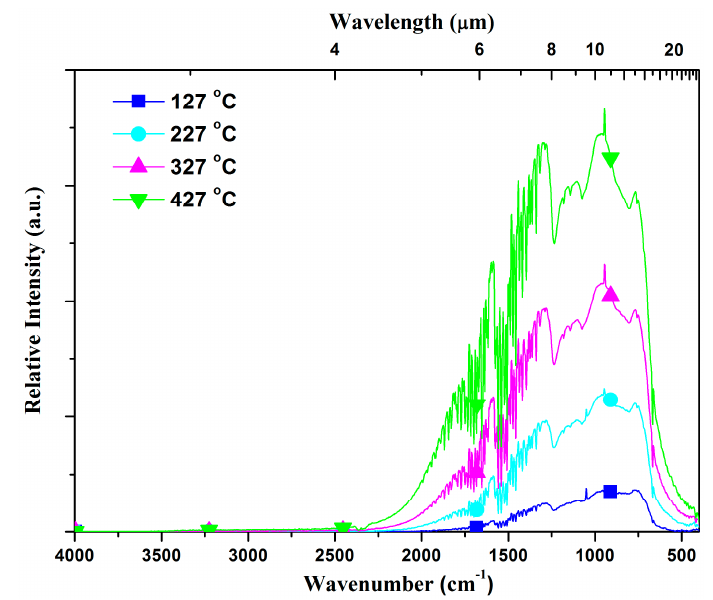
Figure 7. Infrared radiation intensity of a transparent 3Y-TZP sample (25.4 mm diameter, 3.0 mm thick) at high temperature.